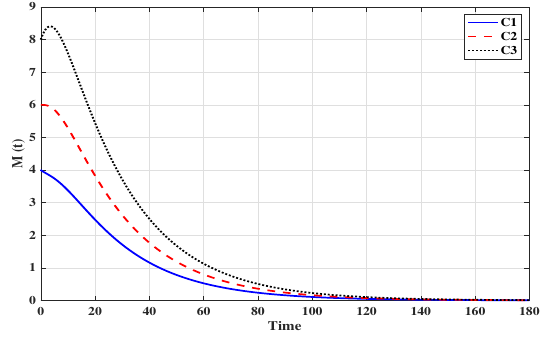
Figure 5. Solutions of system (3) with initials C1–C3 tend to Ξ 3 = ( 7.14,1.3,0,1,0,1.19,0 )